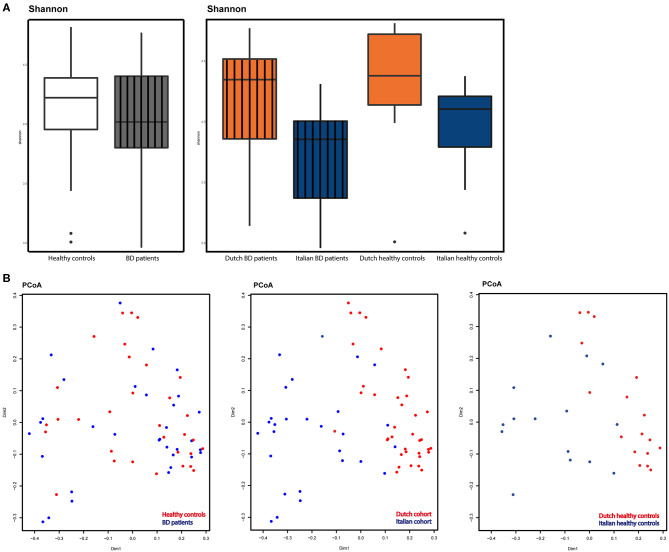
(A) Alpha-diversity as displayed by Shannon index. Left: patients (gray, striped) compared to HC (white). Right: alpha-diversity in Dutch BD patients (striped, orange), Italian BD patients (striped, blue), Dutch HC (orange) and Italian HC (blue). (B) Beta-diversity as displayed by principal coordinate analysis (PCoA) based on the Bray-Curtis metric. Left: diversity in BD patients (blue) vs. HC (red). Middle: diversity compared between countries, Italy (blue) vs. the Netherlands (red). Right: diversity compared between countries in healthy controls, Italy (blue) vs. the Netherlands (red).